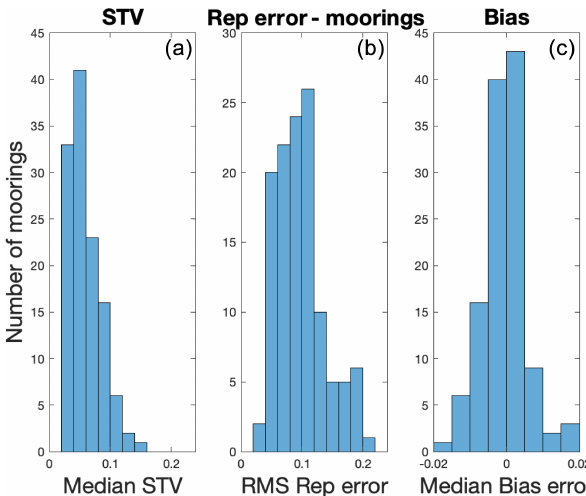
Figure 5. (a) Histogram of the median STV values shown in Fig. 4. One mooring is not included in this figure, an outlier with an STV ≈ 0 . 3 – the large symbol near the coast of Africa in Fig. 4b. Panel (b) is the same as panel (a) but for the RMS representation error shown in Fig. 6. Panel (c) is the same as panel (a) but for the bias error. Positive bias error means an instantaneous value greater than the short-term mean. Note that panels (b) and (c) rely on choos- ing random values from each short-term ensemble. This was done a number of times with different random values with only minor differences in results. Also note that the distributions depicted here included a small number of outliers that are not shown for clarity. Note the different x axis limits in panel (c)